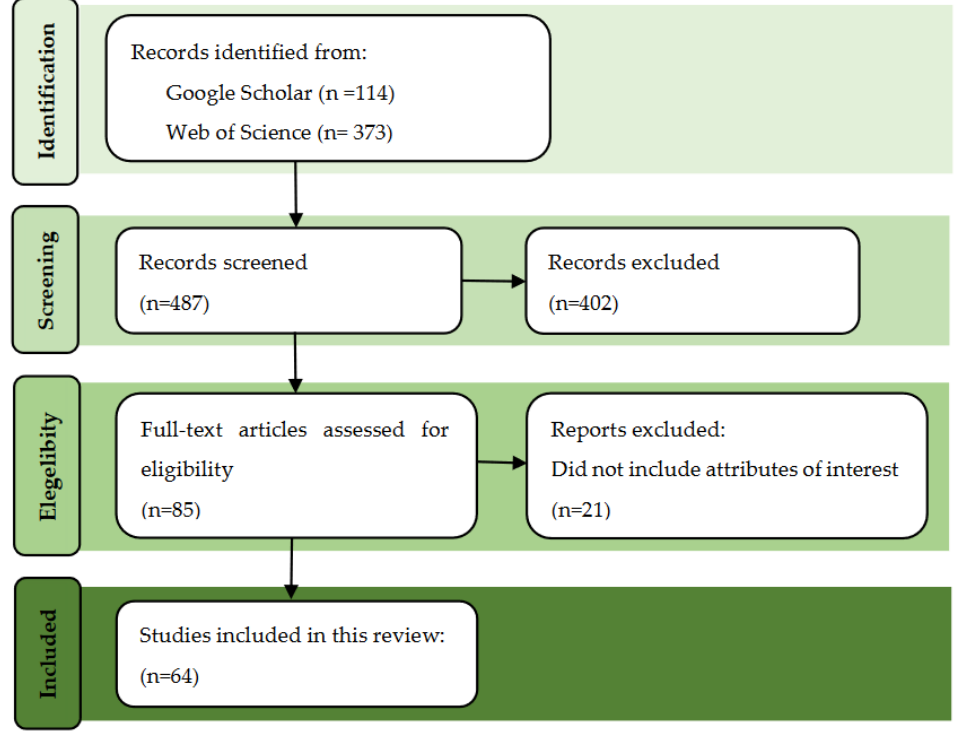
Figure 1. PRISMA flow diagram for study selection.